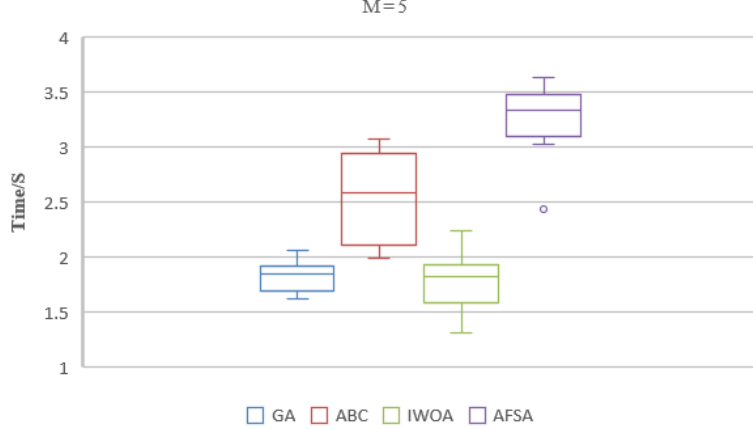
Figure 11. Box plot of run results when the population is 30.